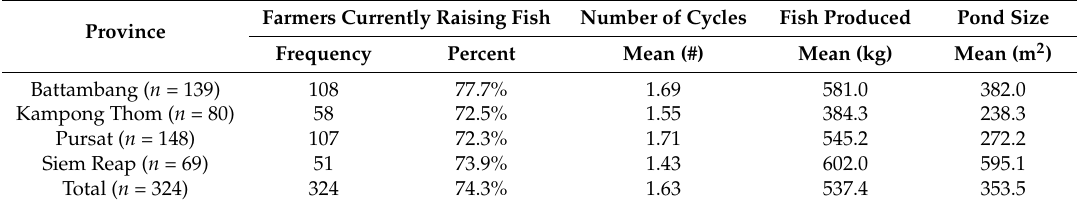
Table 3. Fish production among aquaculture clients, by province.